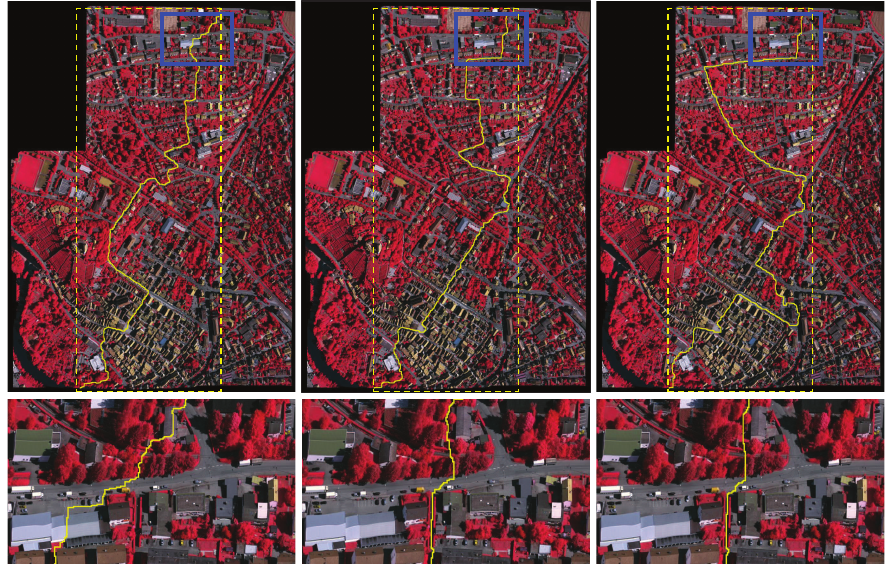
Figure 7. The seamline detection results generated by using different weights: w = 0.0, w = 0.4, and w = 1.0 from left to right. The dash boxes represent the overlapped regions between input images.